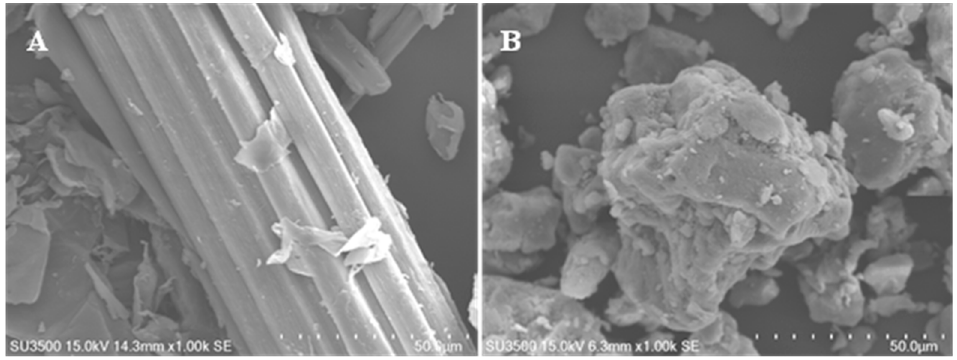
Figure 4. SEM images of CSC ( A ) and CTA ( B ).